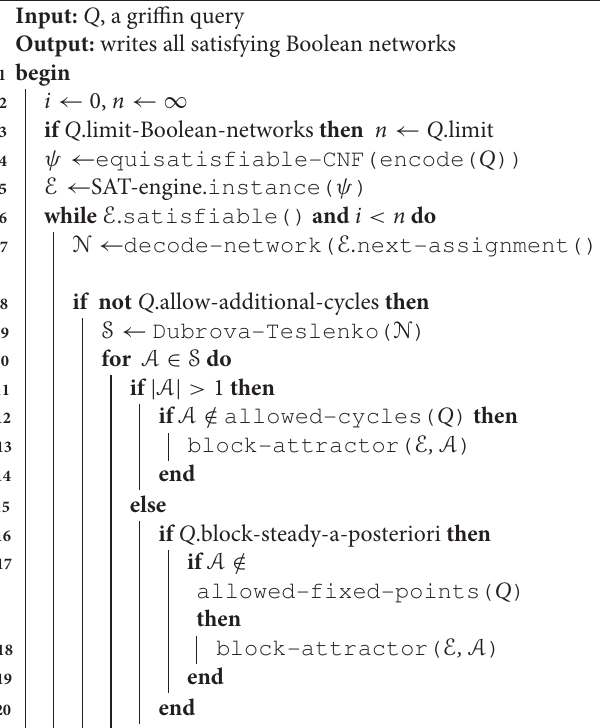
Algorithm 1: Griffin strategy for network